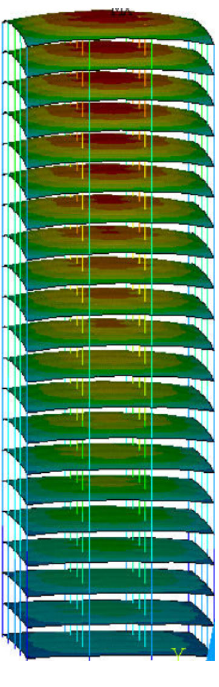
Fig. 11 Vibration mode of the office tower at 4 Hz